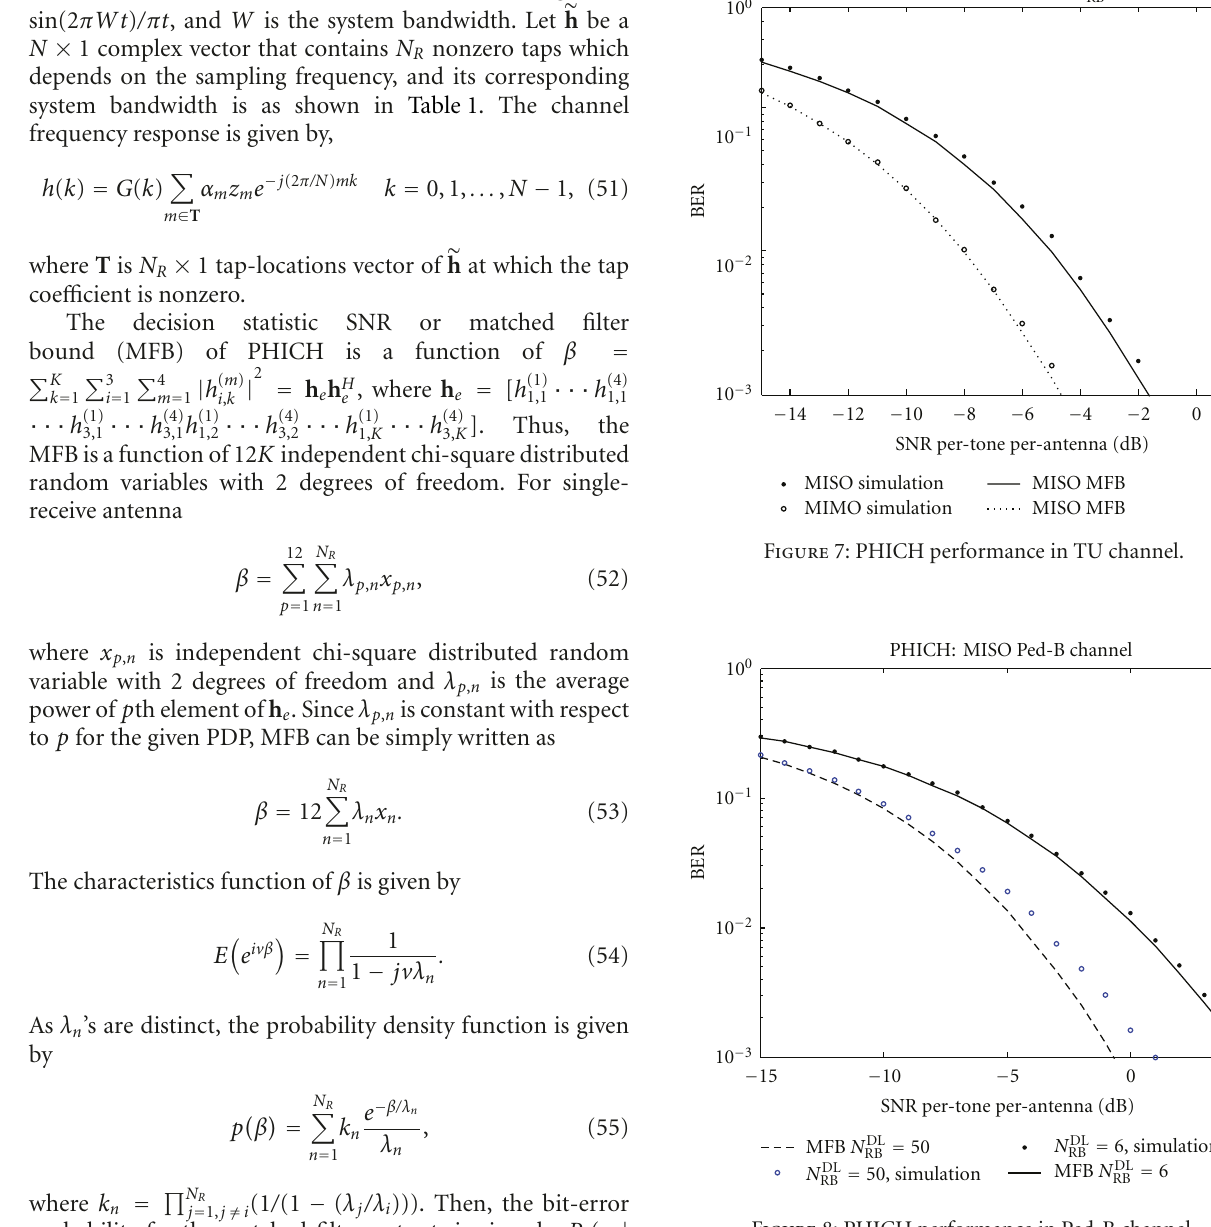
Figure 8: PHICH performance in Ped-B